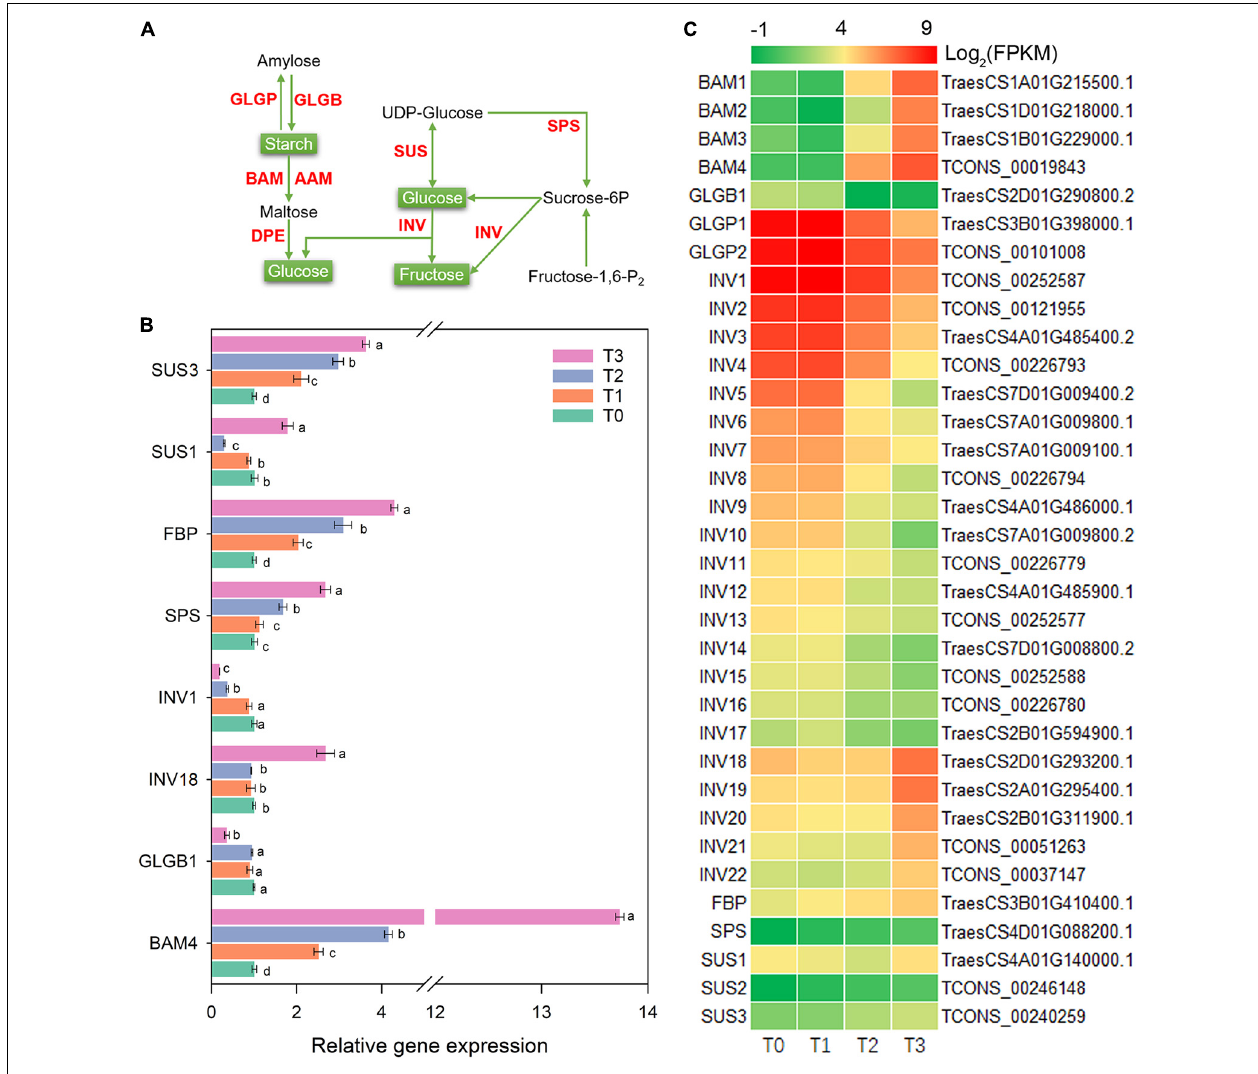
FIGURE 5 | Genes involved in starch and sucrose metabolism. AAM, α -amylase; BAM, β -amylase; DPE, 4- α -glucanotransferase; GLGB, 4- α -glucan branching enzyme; GLGP, amylophosphorylase; INV, β -fructofuranosidase; SPS, sucrose-6-phosphate synthase; FBP, fructose-1,6-bisphosphatase; SUS, sucrose synthase. (A) Pathway map of starch and sucrose metabolism. (B) Verification of the expression of some genes in the pathway. Data are the mean values of four independent replicates ( n = 4), and error bars show the standard error. Duncan’s multiple-comparison test was used for ANOVA, and different lowercase letters indicate a significant difference at the level of P < 0.05. (C) Heatmap of differentially expressed mRNAs in this pathway. T0, T1, T2, and T3 means the sample was harvested at 0, 2, 24, and 72 h after mowing, respectively.